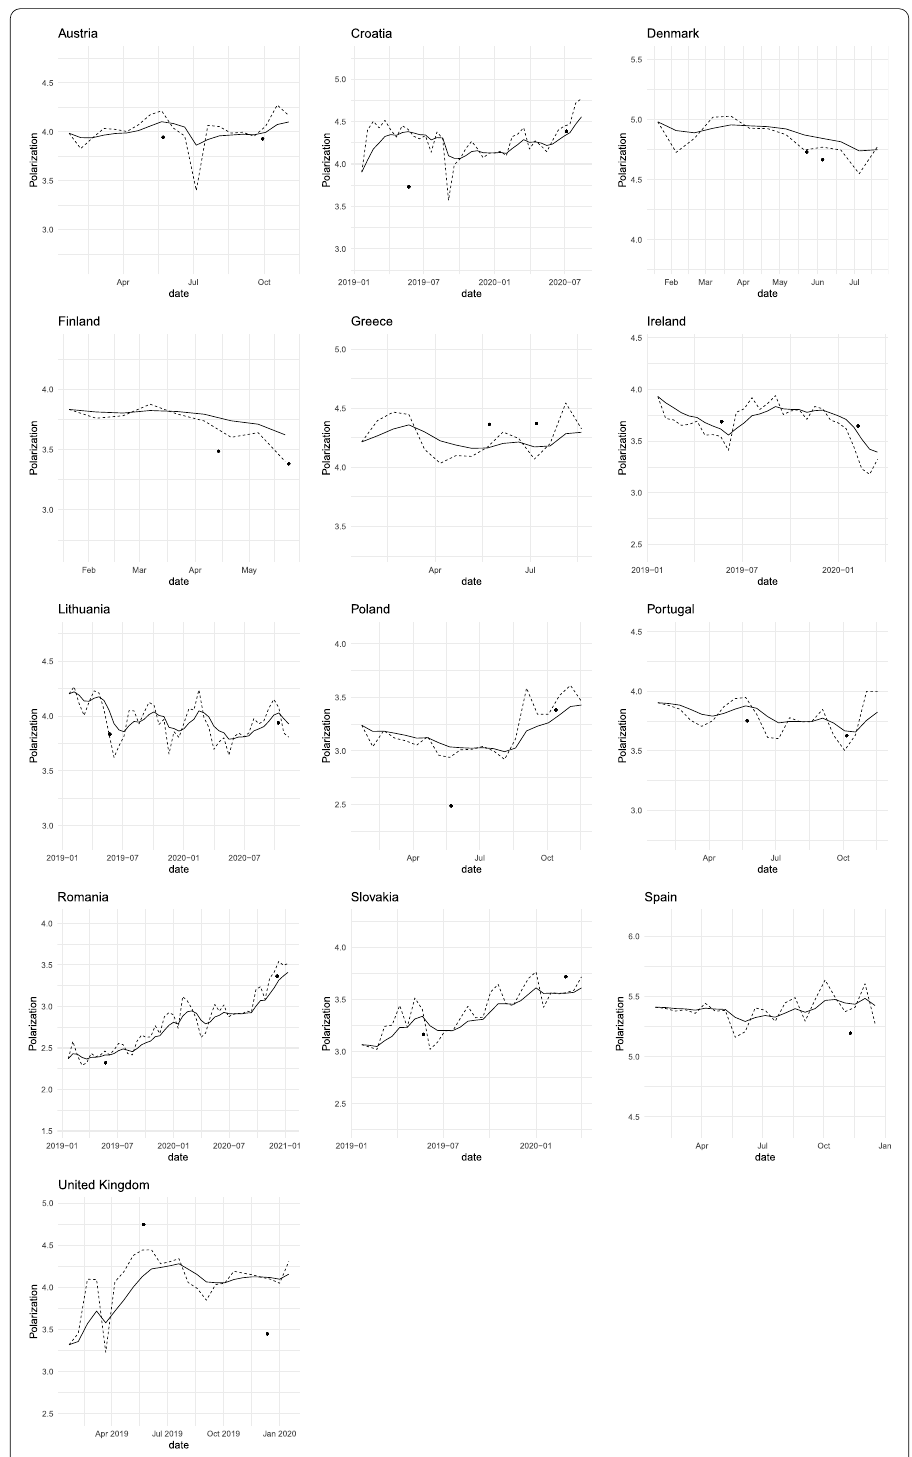
Figure 20 Polarization evolution in European